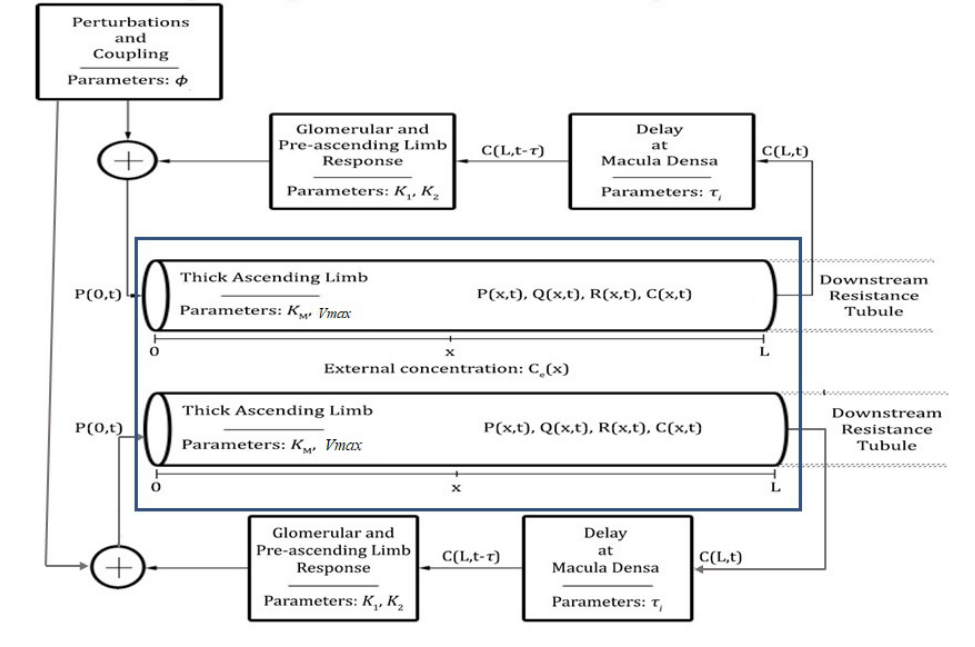
Fig. 1. Block diagram of coupled nephron